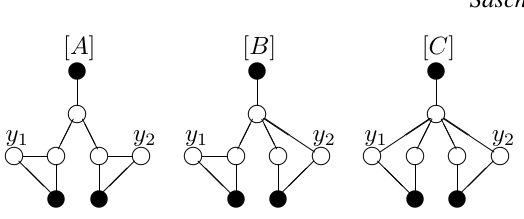
Fig. 22: Extensions of a maximum backbone tree of type 2.